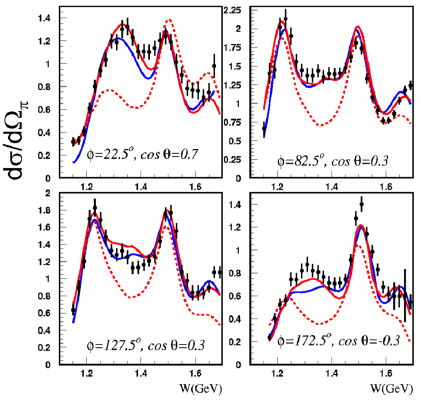
Fig. 2. (Color online) Single pion electroproduction g v p ® n p + cross sections [9] for Q 2 = 2.05 GeV 2 with model fits [10] (red solid line – DR, blue solid line – UIM, red dotted – DR without N(1440)1/2 +